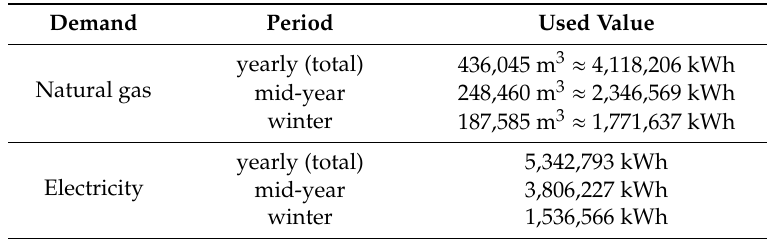
Table 3. Demands of the manufacturing plant assumed in the case study. Note that heating demands are calculated from the natural gas consumed with a 34 MJ / m 3